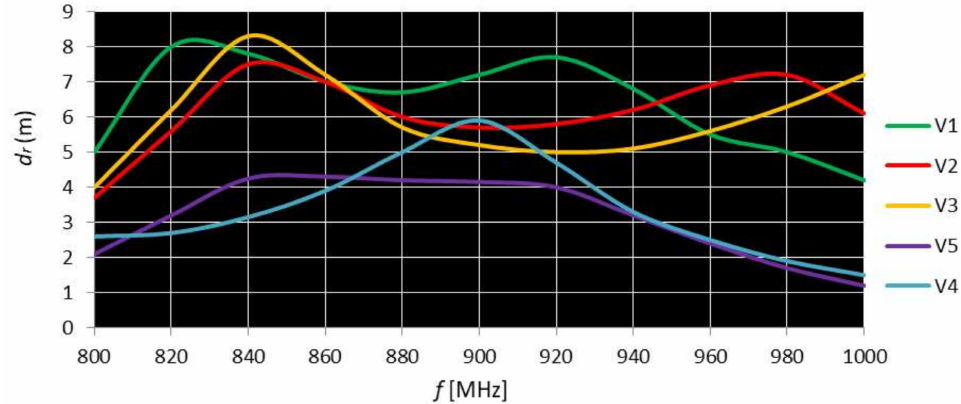
Figure 12. The read range as a function of frequency for double and single coupling loop